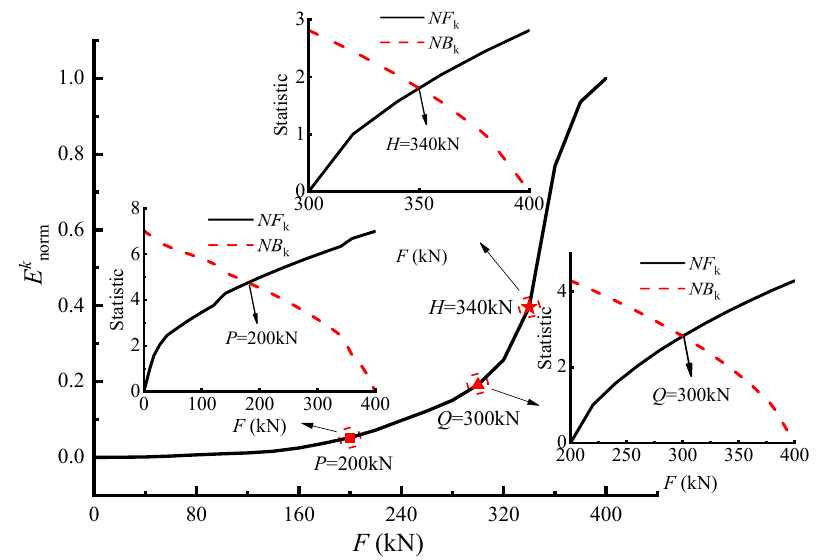
Figure 6. The E k norm – F and M–K statistic k E – F and M–K statistic curves. Figure 6. The norm